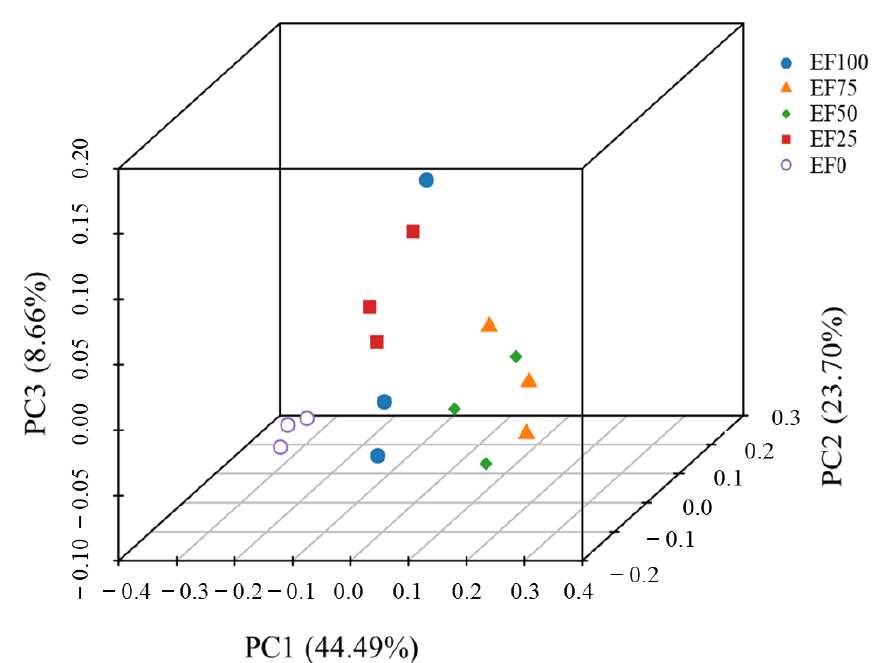
Figure 4. Principal coordinate analysis (PCoA) of sheep rumen microbiota at the level of the op- erational taxonomic units (OTUs) based on Bray − Curtis analysis of different levels. The percent variation explained by principal coordinate 1 (PC1) was 46.74%, whereas that explained by PC2 was 23.70%, by PC3, 8.66%. EF0, EF25, FE50, EF75, and EF100 are defined as EF replacement ratios of 0%, 25%, 50%, 75%, and 100% of the fermentation substrate, respectively.